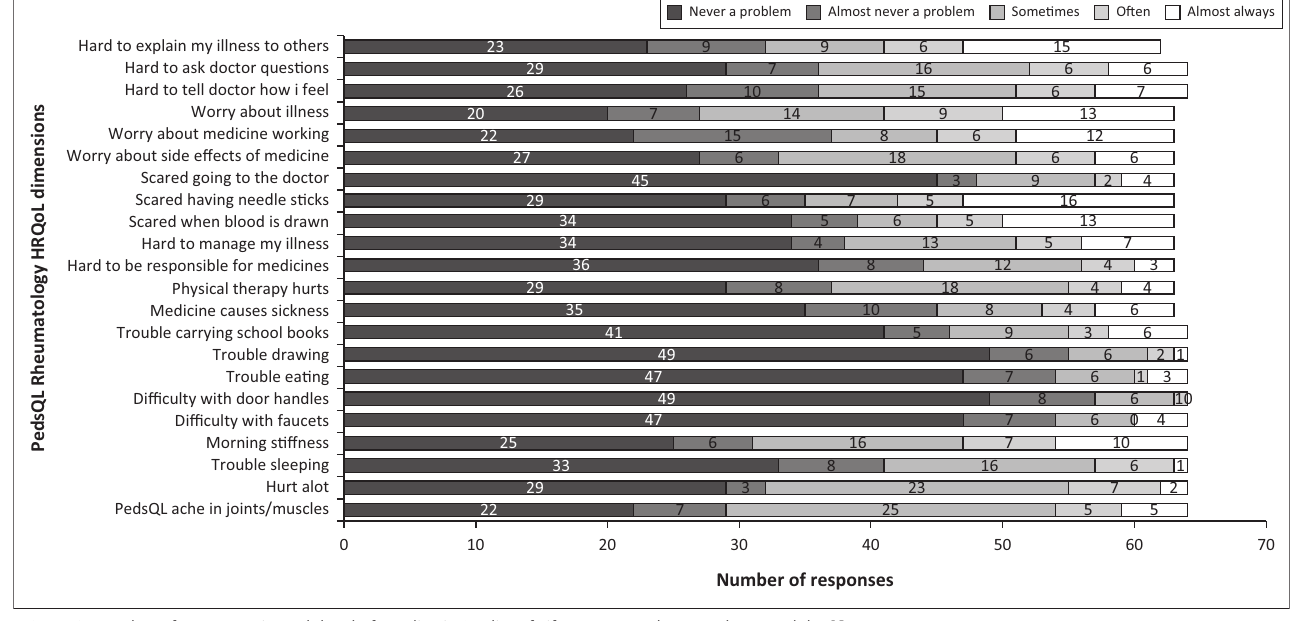
FIGURE 3: Number of responses in each level of Paediatric Quality of Life Inventory Rheumatology Module. N = 64. TABLE 1a: Difference in composite scores of the relevant Juvenile Arthritis Multidimensional Assessment Report scale items across the three different levels of comparable EuroQol five-dimensional youth questionnaire dimensions. EQ-5D-Y